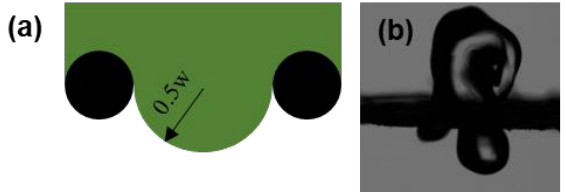
Figure 5. ( a ) Schematic diagram of the Laplace pressure that holds the water above the superhydro- phobic mesh. ( b ) Instantaneous image of an impacting droplet on the superhydrophobic mesh (NO. 1#).